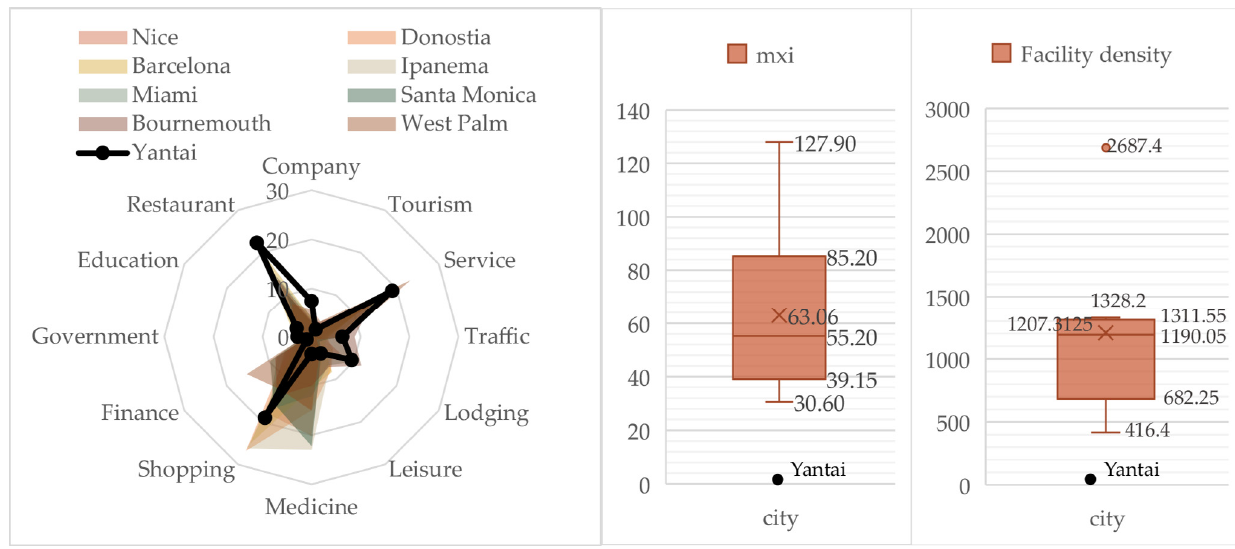
Figure 20. The suggestions for land